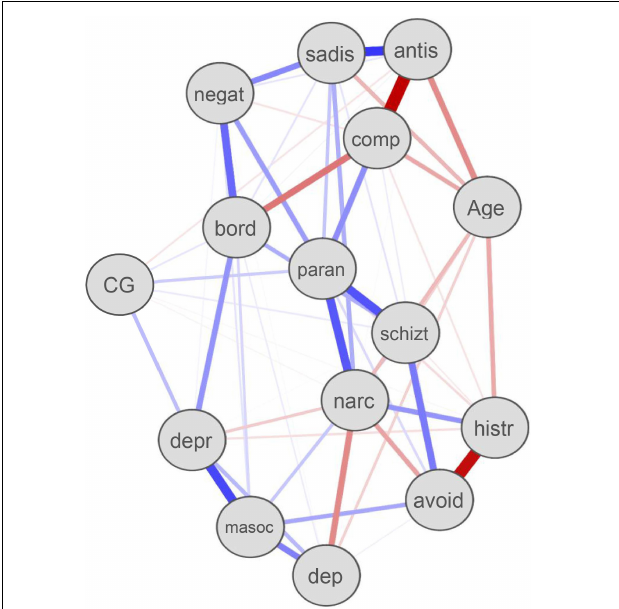
FIGURE 1 | Personality disorders and complicated grief symptoms network. Paran, paranoid; negat, negativistic; narc, narcissistic; bord, borderline; CG, complicated grief; masoc, self-destructive; sadis, sadistic or aggressive; comp, compulsive; antis, antisocial; dep, dependent; avoid, avoidant; histr, histrionic; schizt, schizotypal; depr, depressive.